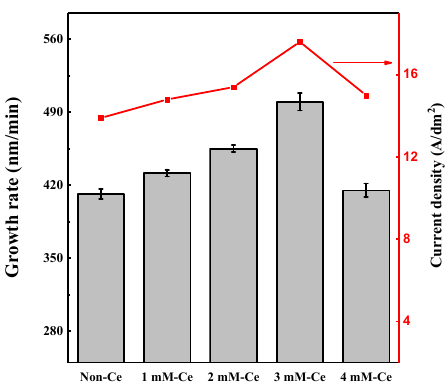
Figure 2. Growth rate of AAO film thickness and current density with change in Ce ion addition.